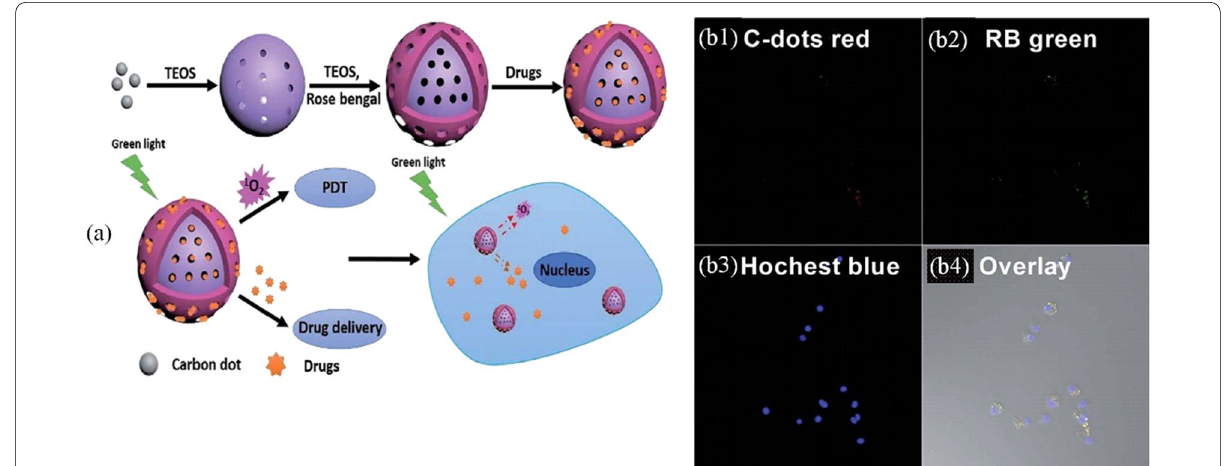
Fig. 5 a Schematic representation of the multifunctional nanoplatform of silica–CDs. b The nanoplatform is localized in the cytoplasm, and the signal is due to the red CDs. All ( b1 – b4 ) images were obtained by confocal microscopy. Reproduced with permission from reference